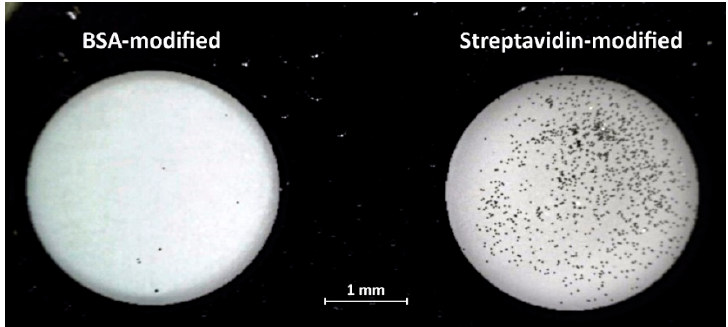
Figure 4. Interaction of biotinylated nano-platelets with the glass surface modified with bovine serum albumin (BSA) and streptavidin.